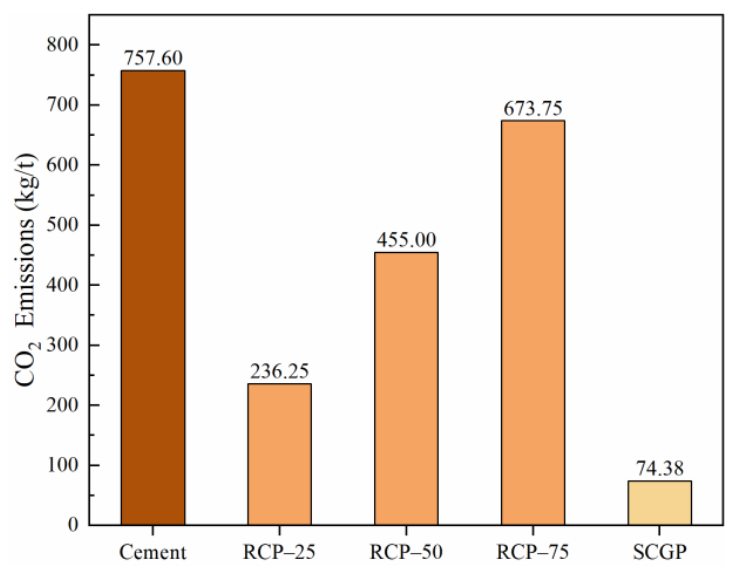
Figure 6. CO 2 emissions from the production process (p i ) of a binder material. In addition to raw material production, material transportation will also consume part of CO 2 [74]. The CO 2 emission generated by transportation (t i ) is related to the transportation distance of each material and the CO 2 generated by the corresponding transportation mode. The data of transportation distance and CO 2 emission by different transportation modes are derived from Xiao et al. [5], listed in Table 4. Referring to the investigation by Xiao et al. [5], for each ton of solid waste reused instead of consigned to a landfill, the CO 2 emission will be reduced by 1.055 kg. The use of RCP or SCGP contributes to reducing the amount of solid waste ending up in a landfill, as a result, reducing CO 2